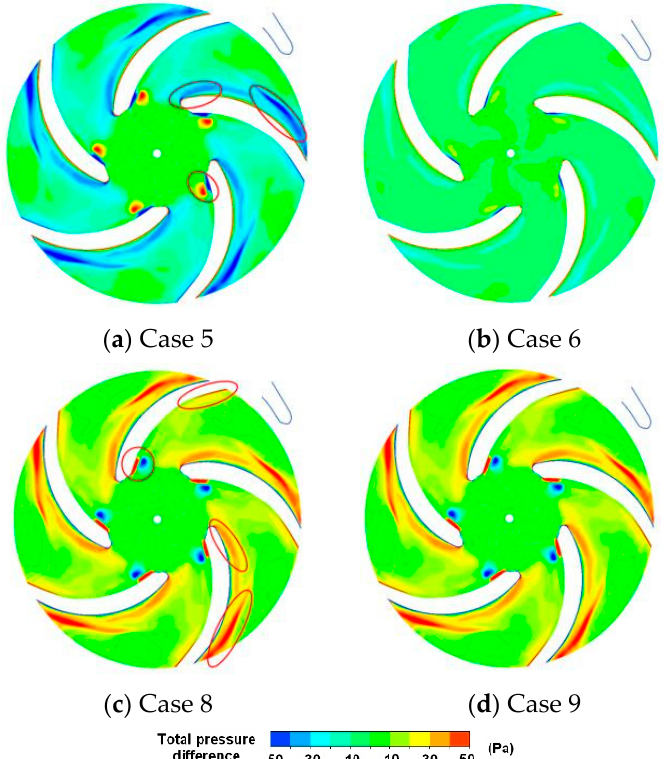
Figure 12. Distribution of total pressure variation on the center plane in the decreasing flow rate section.